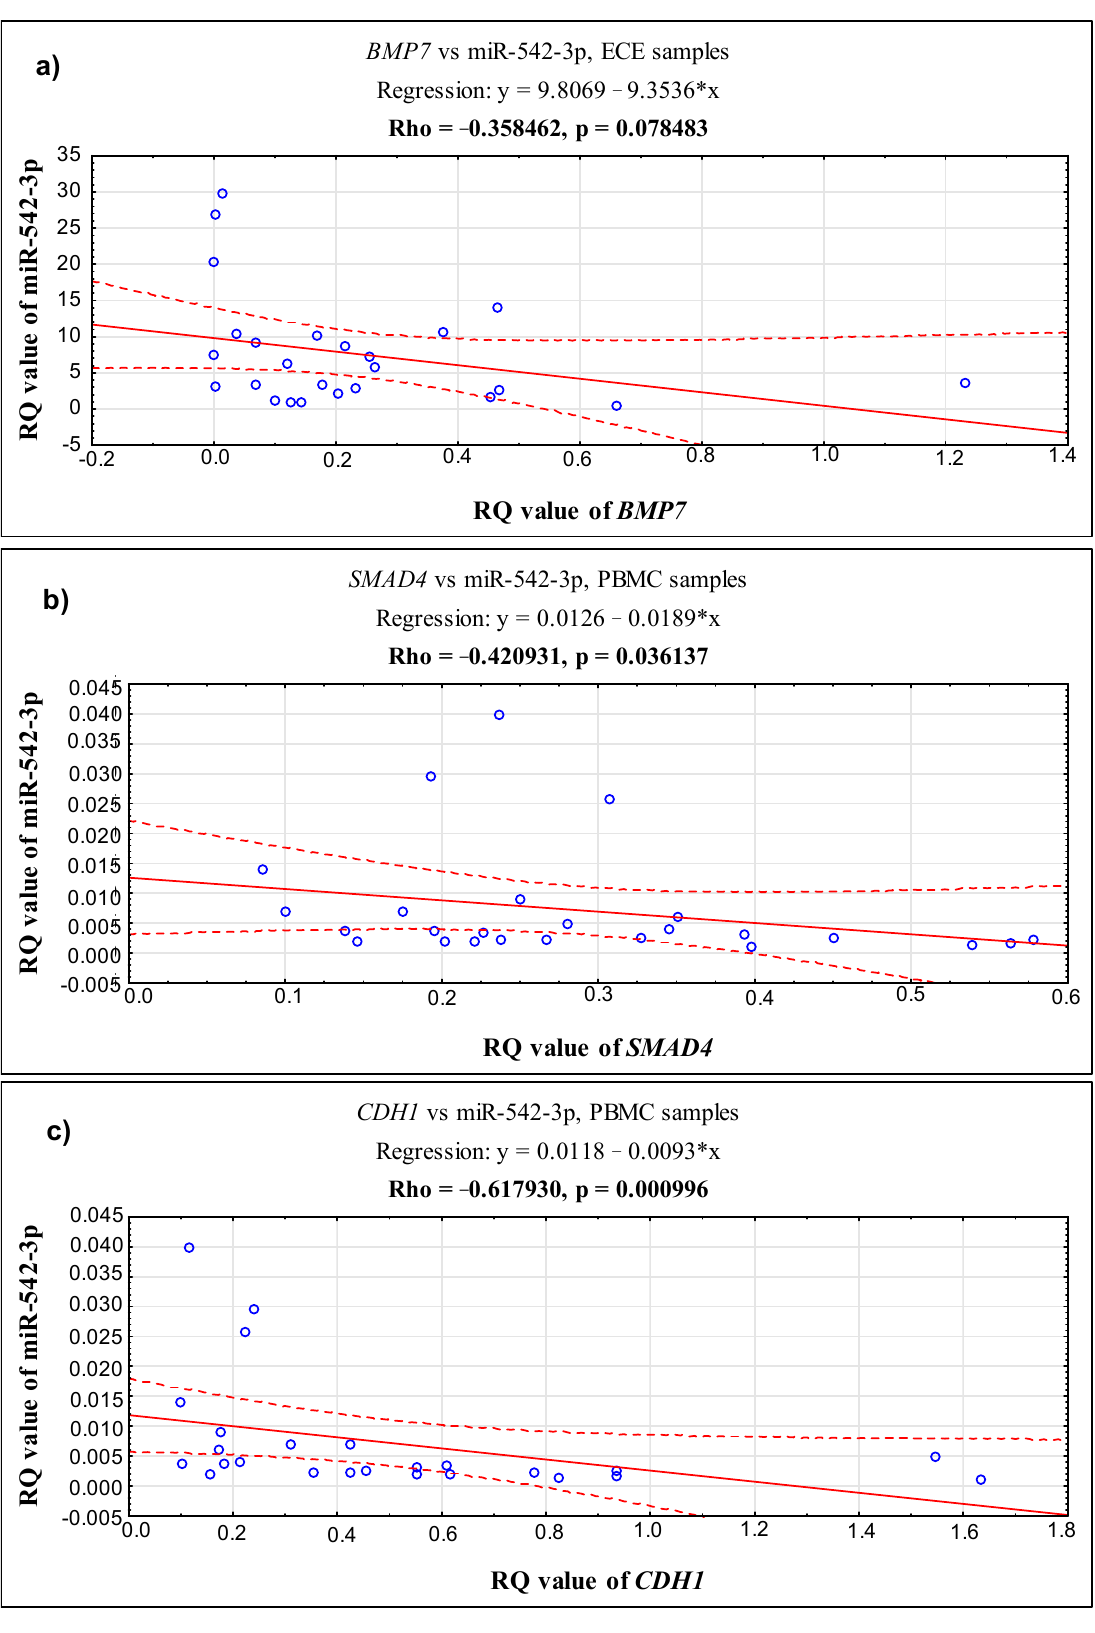
Figure 2. Scatter plots showing correlations between the expression levels (RQ values) of miR-542-3p and genes: ( a ) BMP7 in ECE samples and ( b ) SMAD4 and ( c ) CDH1 in PBMC samples. p < 0.05; Spearman’s rank